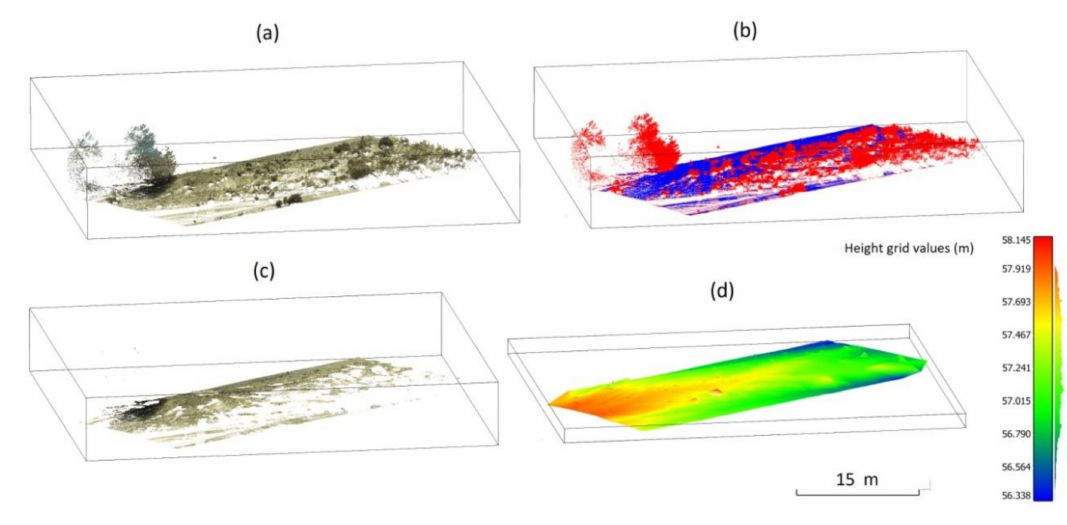
Figure 3. ( a ) View of the raw 3DPC; ( b ) 3DPC classified by means of the CANUPO plugin of CloudCompare, showing in blue the points classified as ground and in red those classified as vegetation; ( c ) 3DPC after removal of the points classified as vegetation; ( d ) the previous 3DPC rasterized using the rasterization tool of CloudCompare, computing the average height for each 5-cm cell and interpolating the empty cells with the nearest